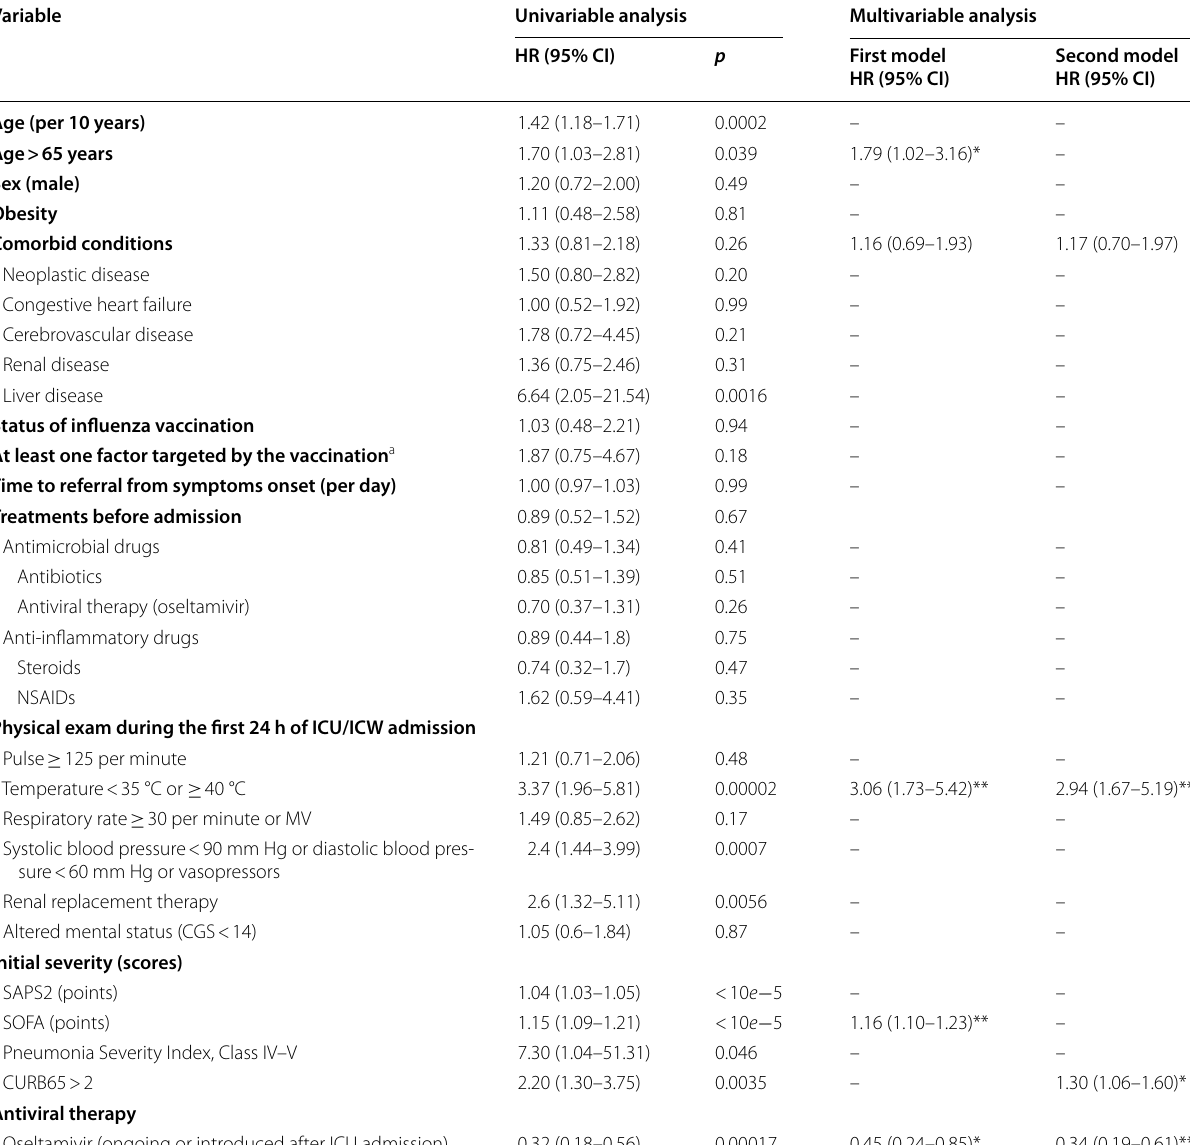
Table 5 Hazard ratios for the risk of death up to day 28 after admission to